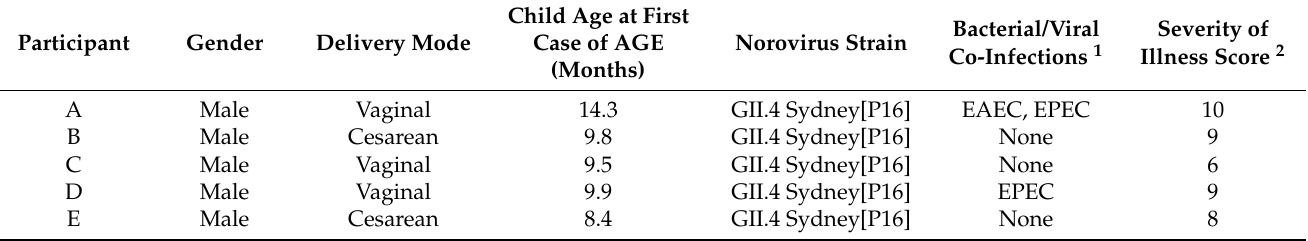
Table 1. Characteristics of the children, their birth, and their first episode of norovirus-associated acute gastroenteritis (AGE) for participants in the Nicaraguan birth cohort submitting stools for microbiome